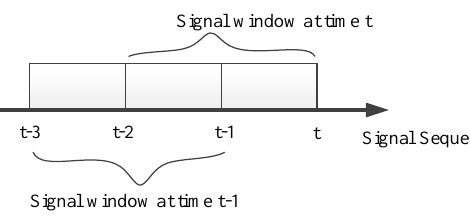
Figure 4. ECG signal refreshment.